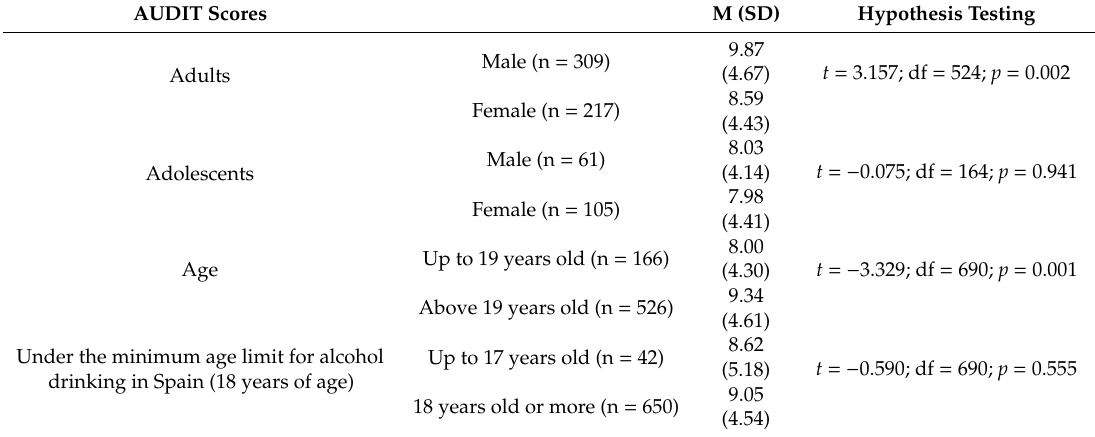
Table 5. Comparison of AUDIT scores by gender and age (for participants with BrAC > 0).